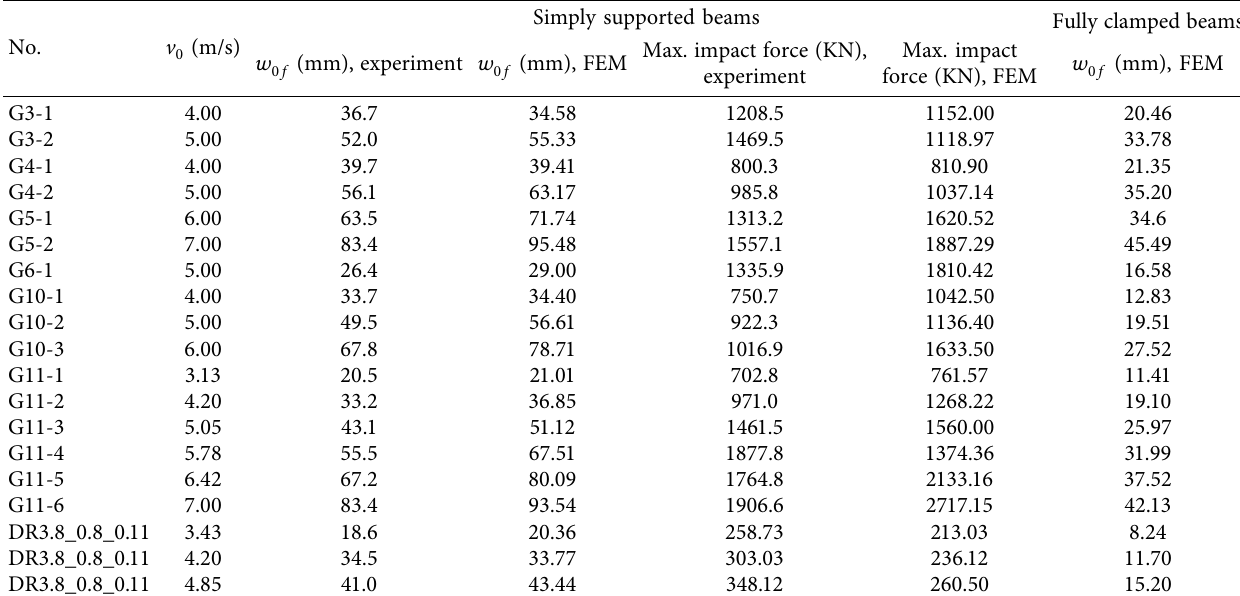
Table 3: List of simulation results.